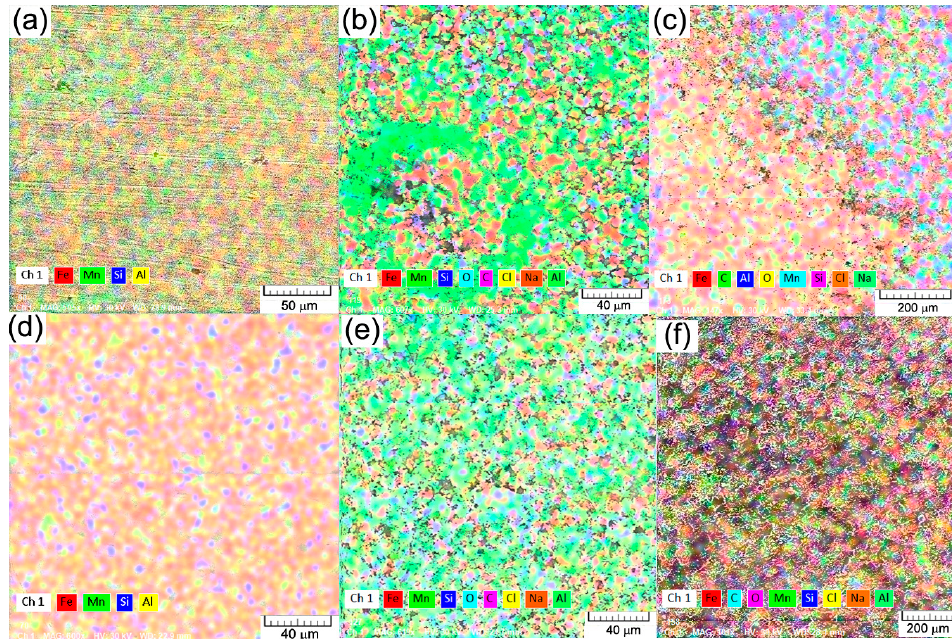
Figure 7. The distribution of chemical elements on the surface for the C sample: ( a ) initial state; ( b ) after 1-day immersion; ( c ) after 7 days immersion; HR: ( d ) initial state; ( e ) after 1-day immersion; ( f ) after 7 days immersion.